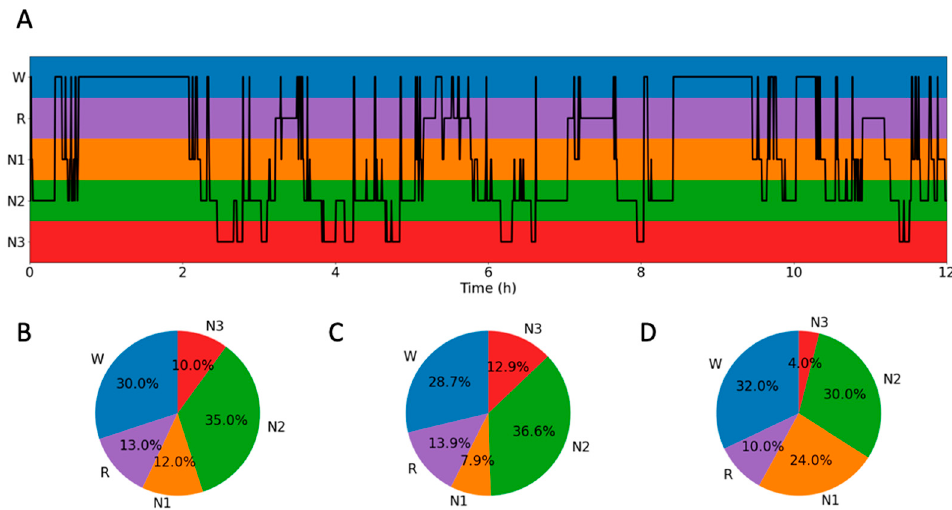
Figure A15. Sleep stages of a 12 h recording. W (blue): wakefulness; R (purple): REM sleep; N1 (orange): non-REM sleep stage 1; N2 (green): non-REM sleep stage 2; N3 (red): non-REM sleep stage 3. ( A ) Overview of the sleep stages. ( B ) Distribution of the sleep stages for the whole recording. ( C ) Distribution of sleep stages for training data. ( D ) Distribution of sleep stages for test data.